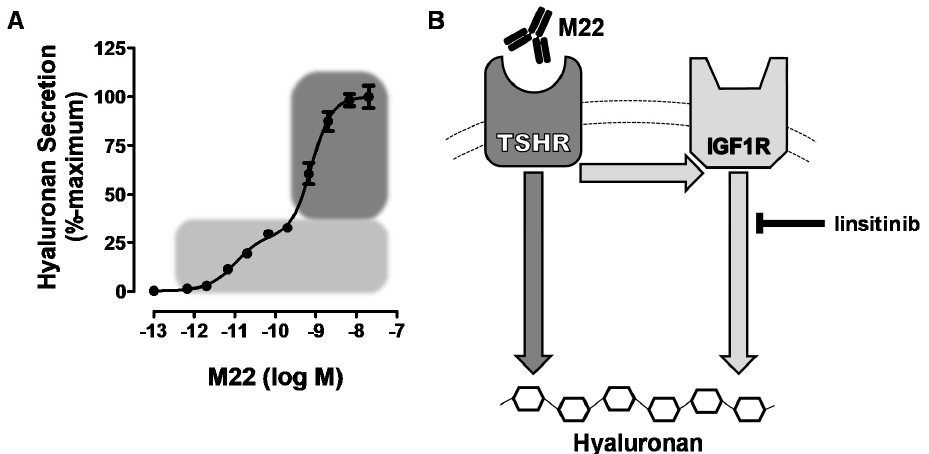
Figure 1. ( A ) model of thyroid-stimulating hormone receptor/insulin-like growth factor 1 receptor (TSHR/IGF1R) crosstalk initiated by M22 binding to TSHR on hyaluronan secretion by Graves’ orbital fibroblasts. Graves’ orbitopathy fibroblasts (GOFs) secrete hyaluronan following stimulation by M22, a human monoclonal TSHR-stimulating antibody. This response to increasing doses of M22 is biphasic (panel A ), as shown by the light and dark gray regions of the curve. The light gray region is the IGF1R-dependent (high potency) phase, which was found by We to be inhibited by linsitinib, an IGF1R kinase inhibitor [27] . The dark gray region indicates the IGF1R-independent (low potency) phase of hyaluronan secretion, which occurs regardless of crosstalk with IGF1R. The cartoon in panel ( B ) depicts the two pathways that mediate TSHR-initiated hyaluronan secretion. The combination of these two pathways leads to full stimulation of hyaluronan. Adapted from [27] .